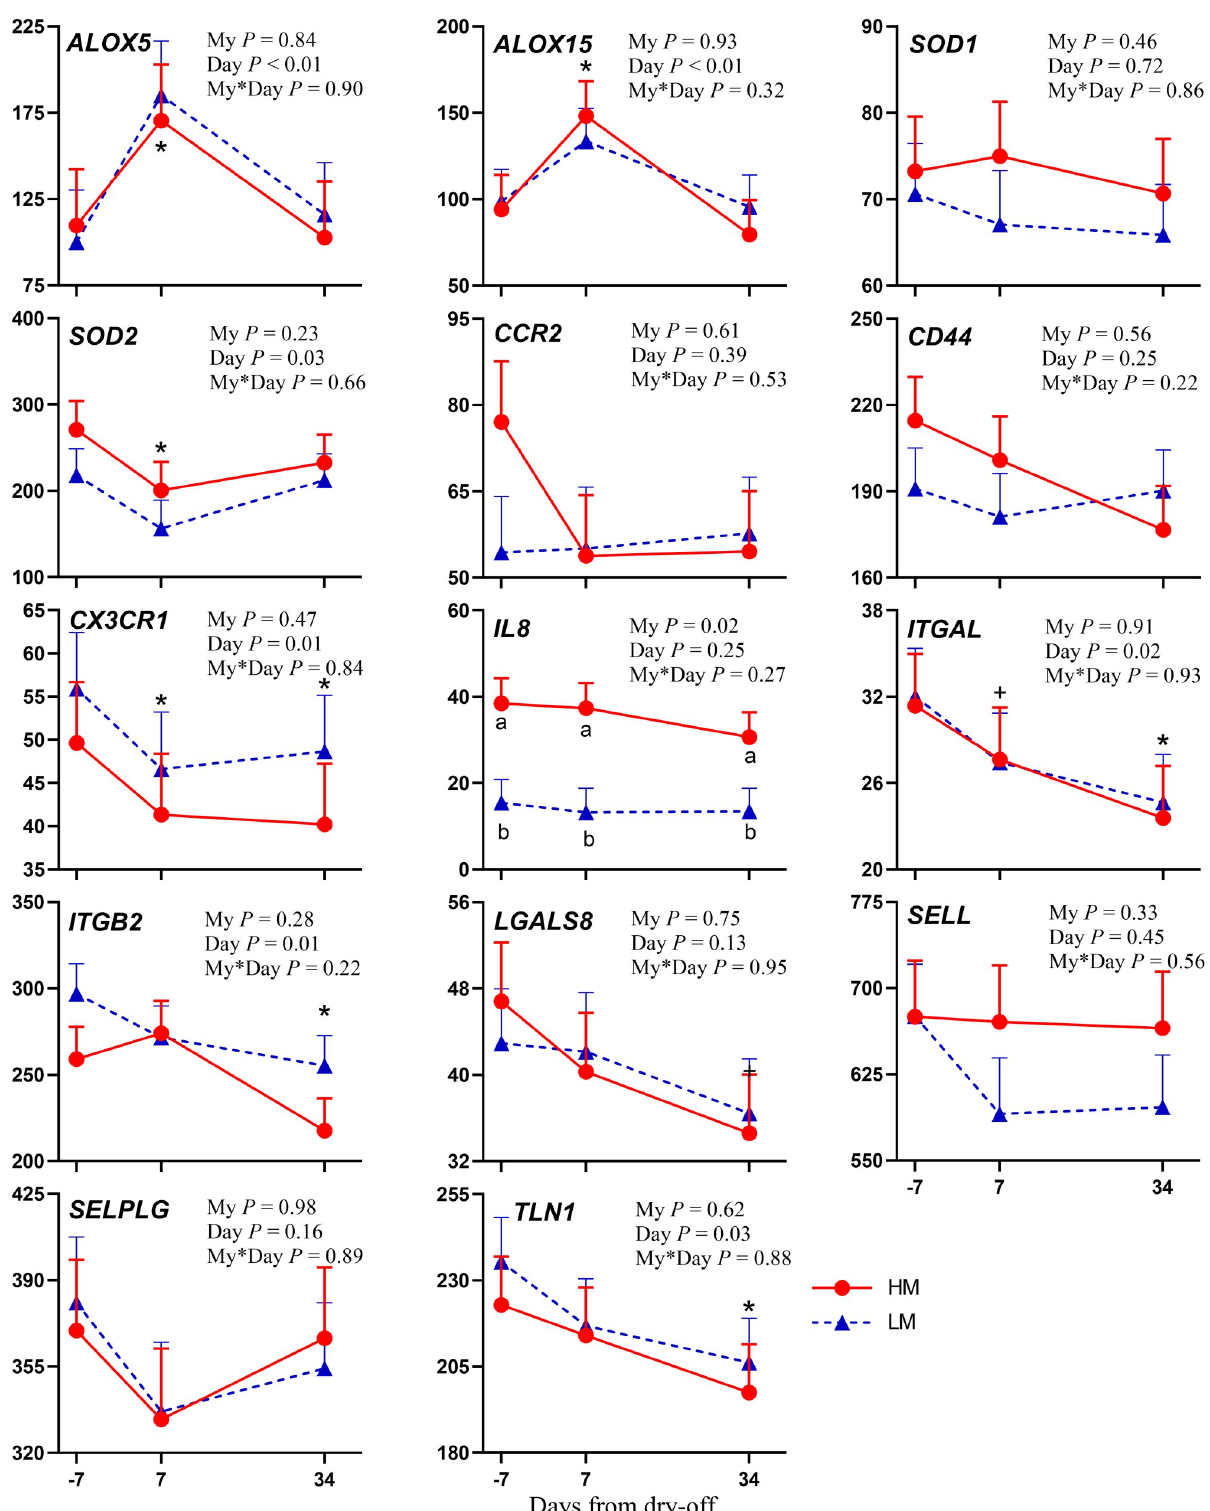
Fig 2. mRNA abundance of genes involved in leukotrienes and oxidative status pathways and migration and cell adhesion. Changes from -7 days from dry-off (DFD) to 34 DFD in dairy cows with high (HM; red line) or low (LM; blue line) milk yield at dry-off in mRNA abundance (mean ± SEM) for gene expression of genes involved in leukotrienes and oxidative status pathways and migration and cell adhesion: ALOX5 (Arachidonate